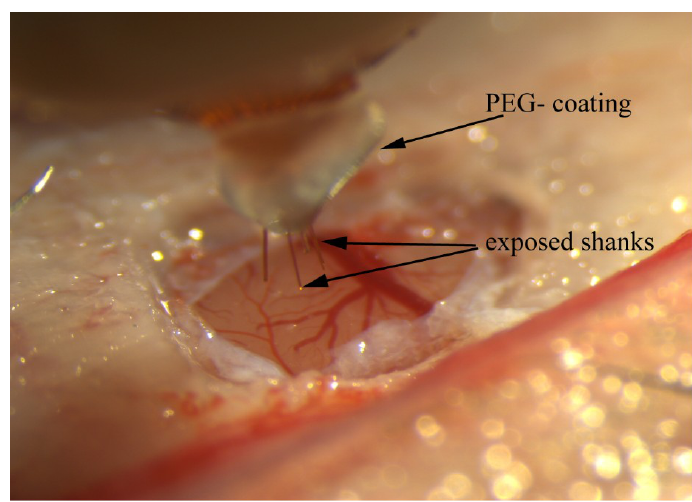
Figure 3. Insertion of a PEG-stabilized a-SiC MEA into rat motor cortex. The PEG temporarily